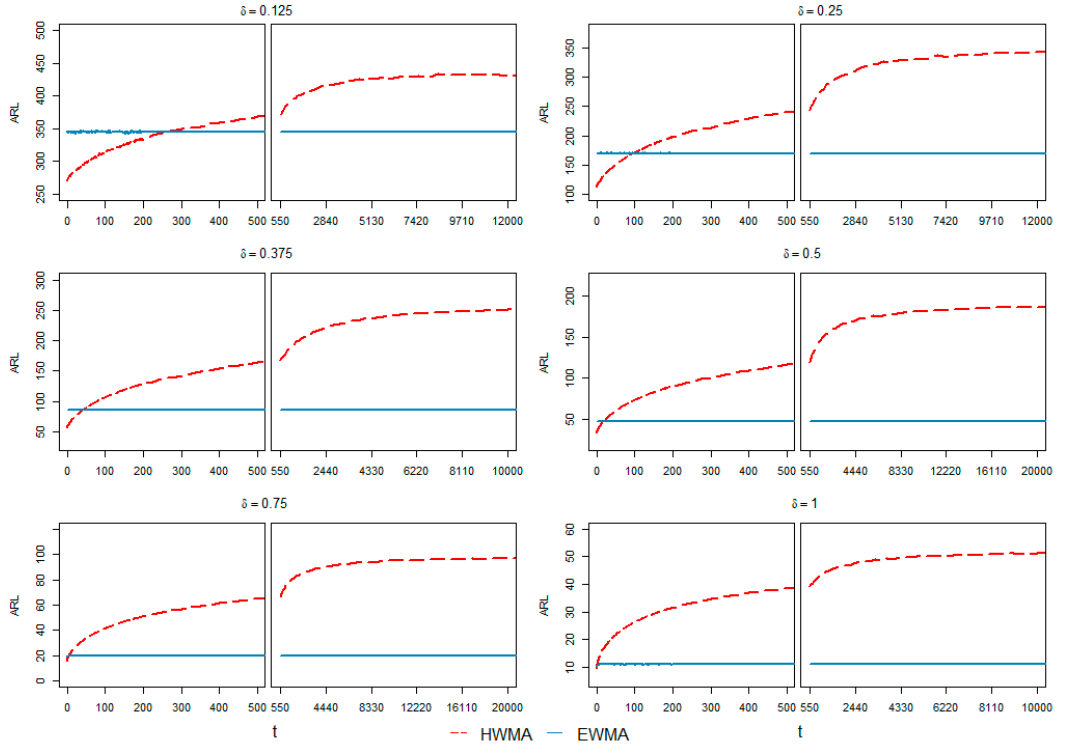
Figure 8. CED curves for the HWMA and EWMA charts under small to moderate shifts at 𝜆 = 0.25 with respect to time points (𝑡) .